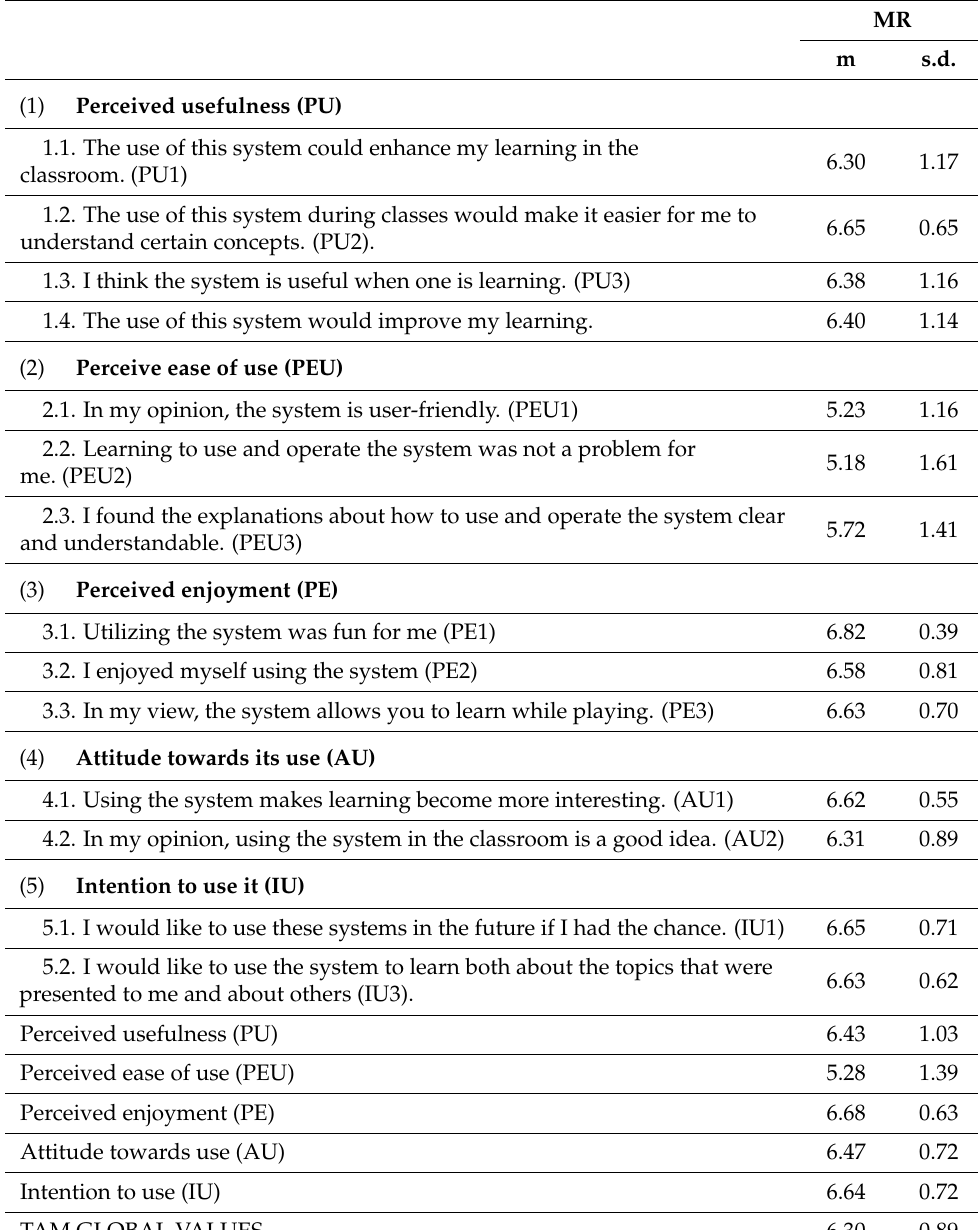
Table 4. Means and standard deviations obtained with